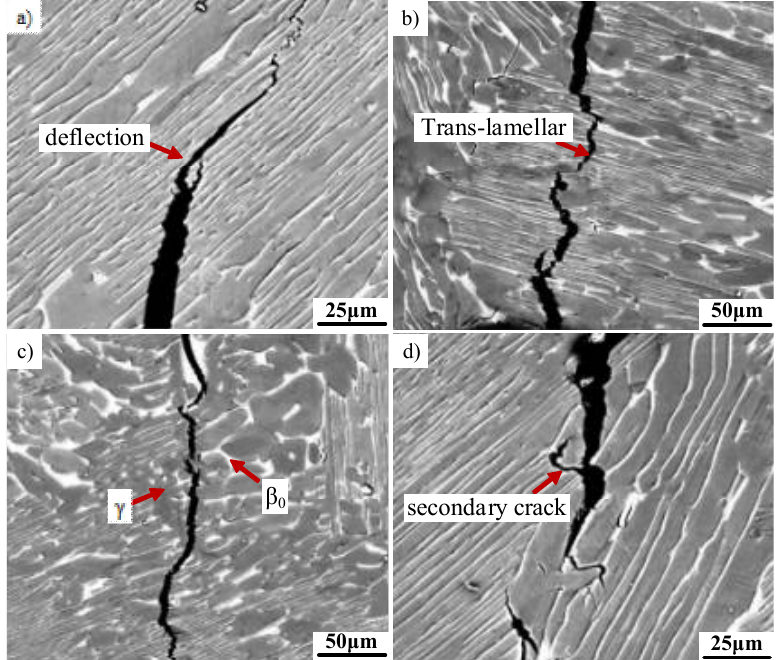
Figure 3. The dependence of crack propagation on γ/α 2 lamellar orientation. ( a ) deflection, ( b ) trans-lamellar crack, ( c ) γ/β 0 region, ( d ) secondary crack.